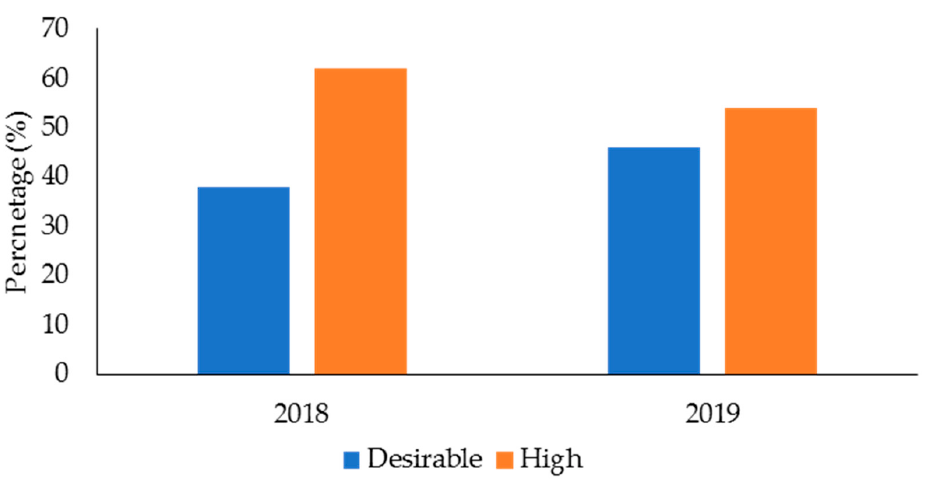
Int. J. Environ. Res. Public Health 2022 , 19 , x Figure 2. Percentage of police officers from a health and wellness program in 2018 and 2019 classified according to the categories for low-density lipoproteins.